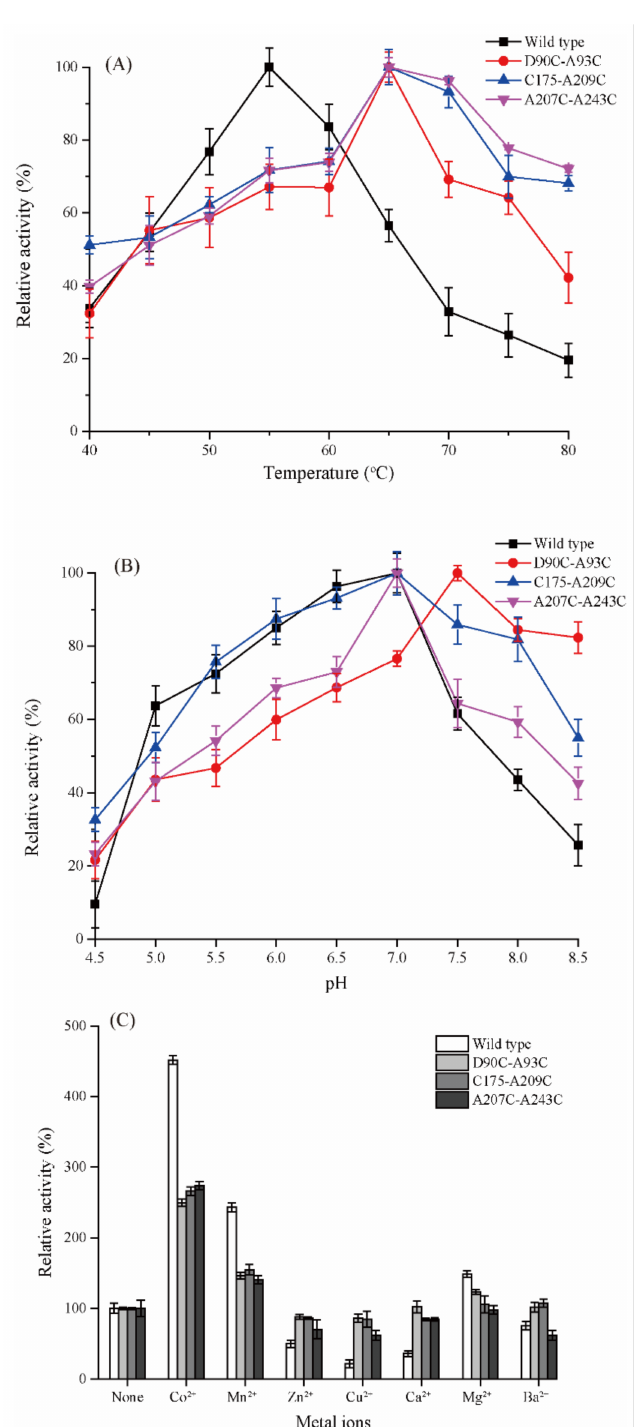
Figure 3. The optimal temperature ( A ), optimal pH ( B ), and effect of metal ions ( C ) of wild type DPEase and the three